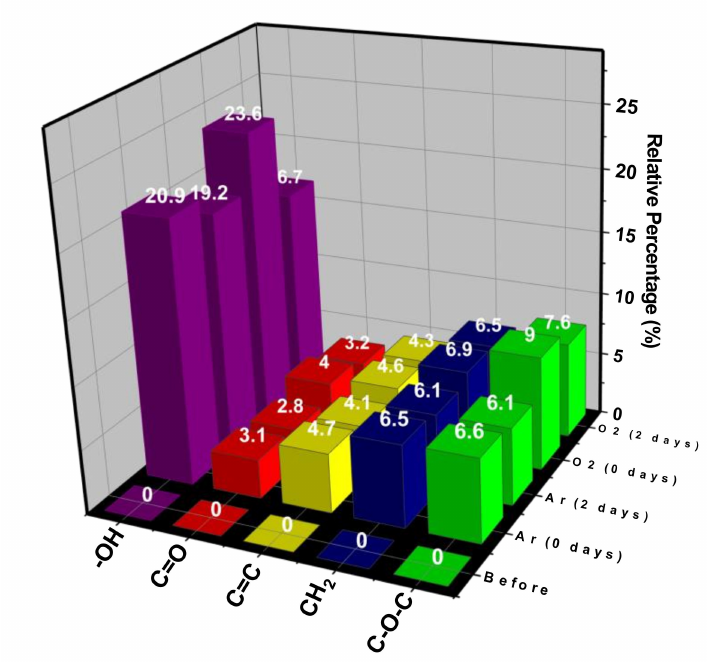
Figure 8. Relative percentages of regions of the other peaks.